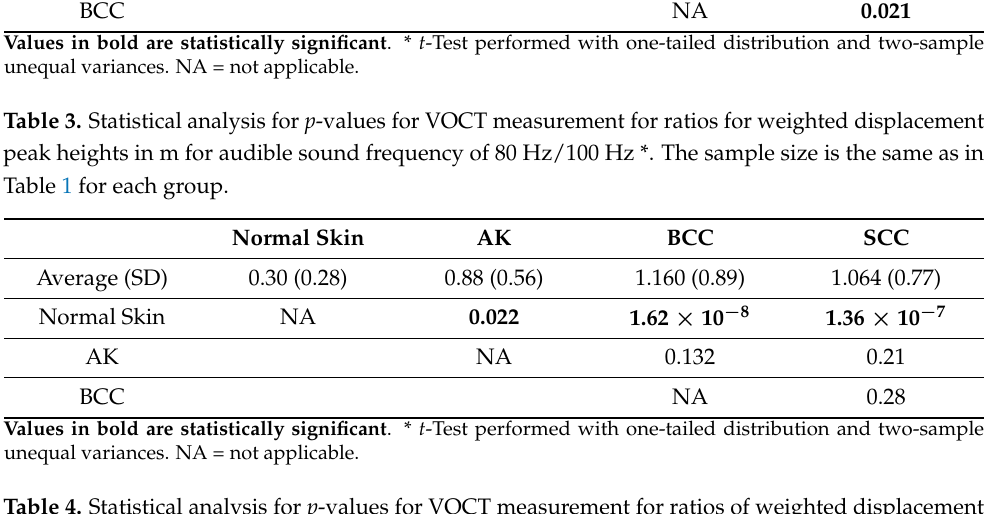
Table 4. Statistical analysis for p -values for VOCT measurement for ratios of weighted displacement peak heights in m for audible sound frequency of 130 Hz/100 Hz *. The sample size is the same as in Table 1 for each group.